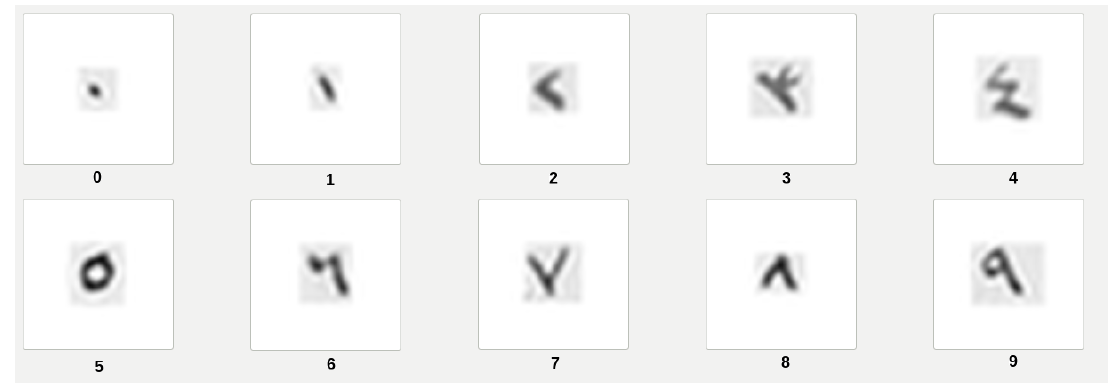
Figure 7. All ten-digit samples from our local data. Fifty digits are selected from the output of the numeral spotting